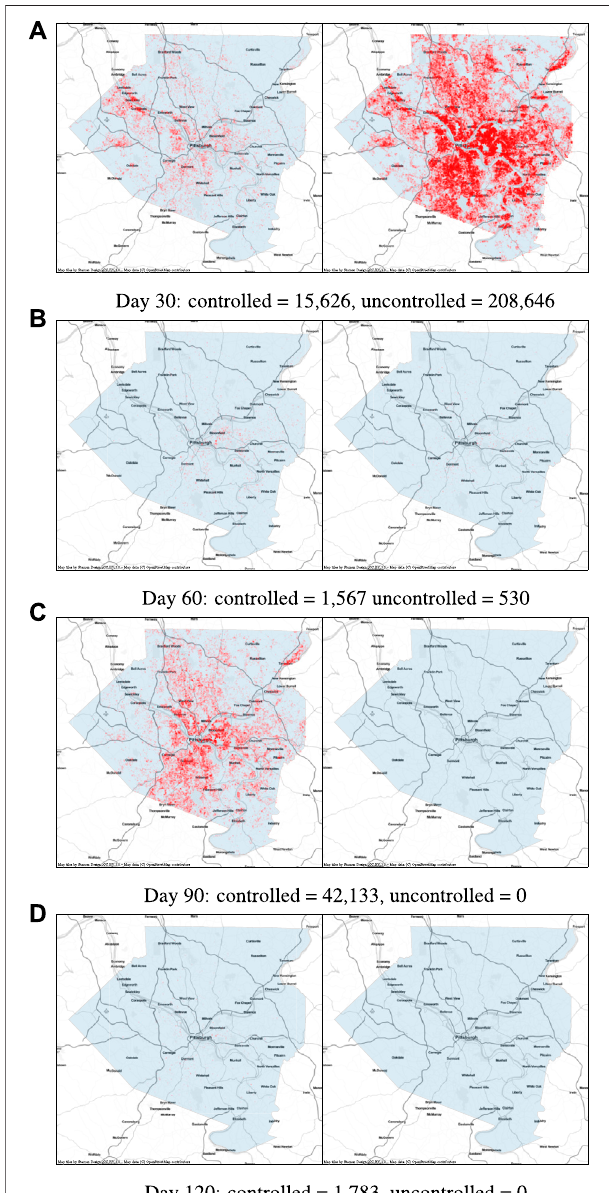
FIGURE 9 | Progression of a simulated in fl uenza epidemic in Allegheny county under controlled (left) and uncontrolled (right) scenarios. Each red dot represents the household of an infectious person. The count of the number of infected households in each scenario appears in the captions below each row. The peak number ofcases inthe uncontrolled scenariois215,799 on day 29, while the peak numberofcases inthe controlled scenariois65, 997 on day 83. We see that the controls we solve for successfully “ fl atten the curve, ” indicated by a much lower density of red dots. There is also a second spike predicted, visible in (C) , where as controls are removed there is an increase in cases throughout the susceptible portion of the population. However, this second spike is still below the required threshold.